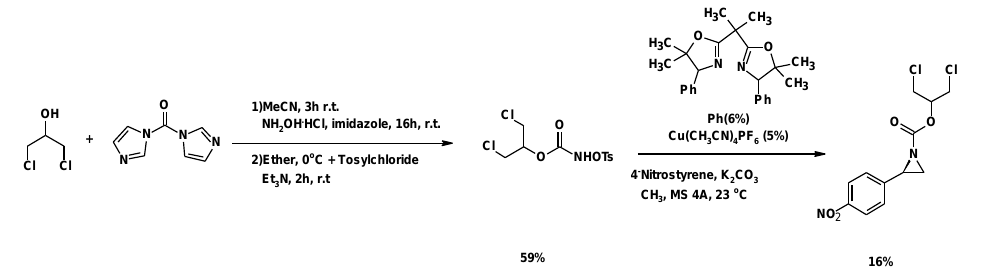
Figure 16. Synthesis of aziridine derivatives using 1,3-DCH.